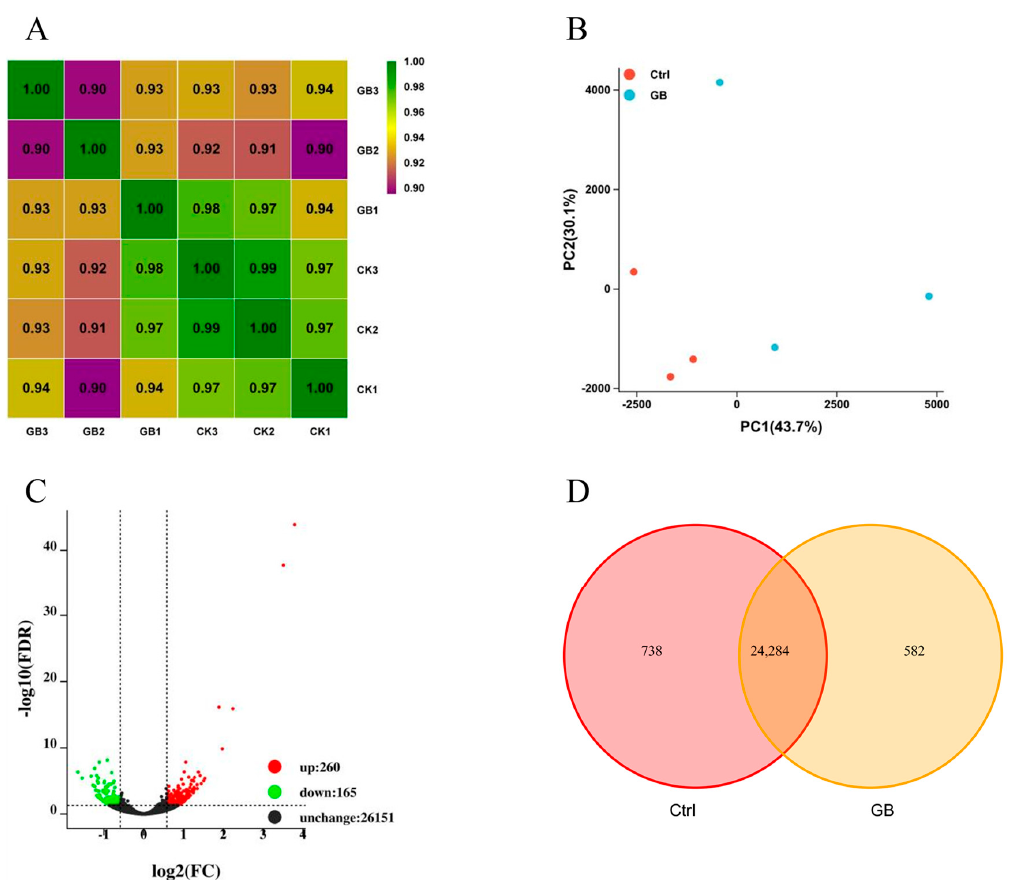
Figure 4. RNA-Seq data analyses. ( A ) Heatmap of correlations between samples in different treat- ments showing three GB and three control (CK) groups. Each value in the heatmap is a Pearson’s correlation coefficient. ( B ) PCA analysis plot displaying all 6 samples along the axes of PC1 and PC2, which describe 43.7% and 30.1% variability, respectively, within the expression dataset. ( C ) Volcano plots of the overall DEGs distribution. Threshold was set as an adjusted p -value (Padj) < 0.05 in GB relative to Ctrl. X-axis depicts fold change (FC) in gene expression where the smaller the value, the higher the expression relative to Ctrl. Y − axis depicts false statistical signi fi cance of false discovery rate (FDR), where the bigger the value, the smaller the ratio of the number of false positives to the number of total positives. Signi fi cantly up − regulated and down − regulated genes are indicated in red and green, respectively. Genes that were not di ff erently expressed are depicted in black. ( D ) Venn diagram of expressed genes in GB and control under heat stress.